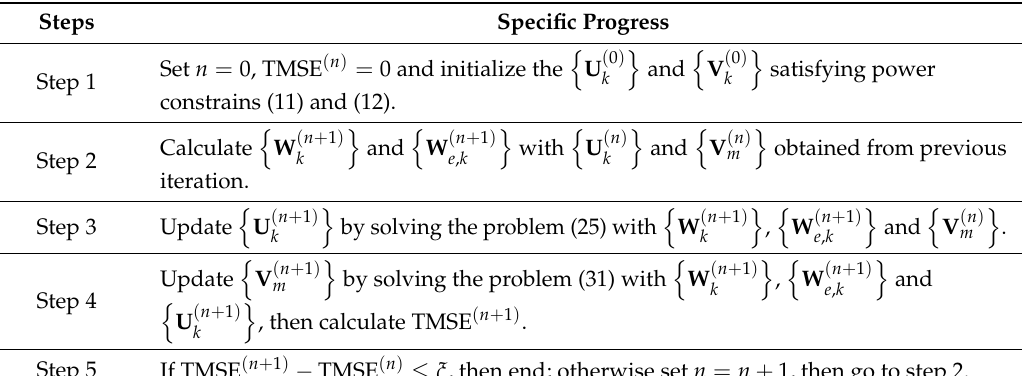
Table 1. The proposed iterative distributed algorithm for problem